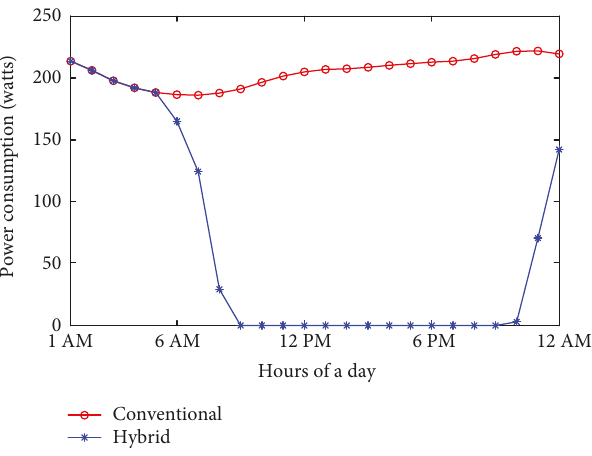
Figure 6: Comparison of on-grid power consumption in a single BS between the existing hybrid energy model (no sharing) and the conventional scheme with grid supply only. No CoMP technique is implemented in the network models.